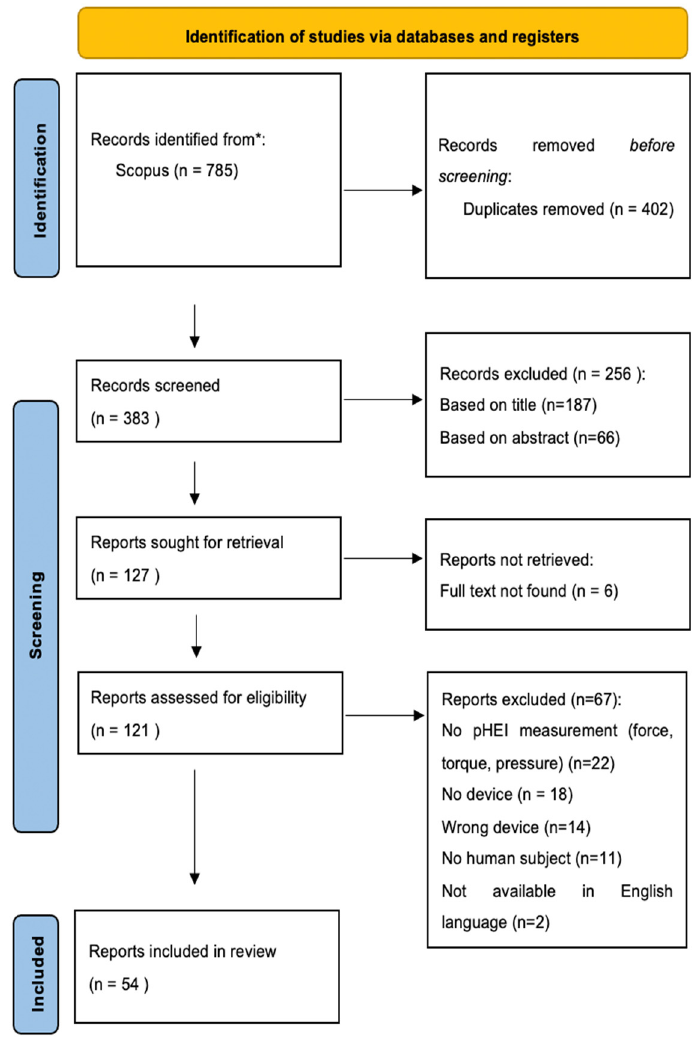
Figure 1. Prisma diagram of the conducted review.